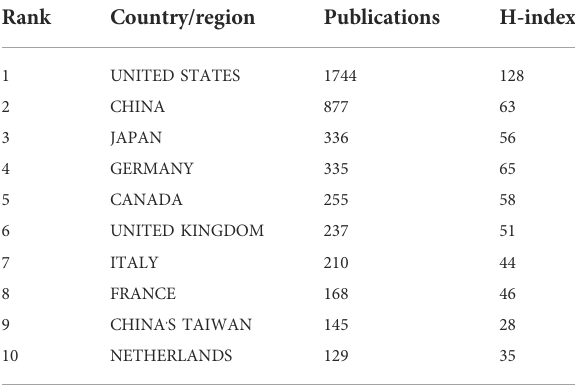
TABLE 1 Top 10 the most productive countries/regions on mitochondrial function and heart failure.